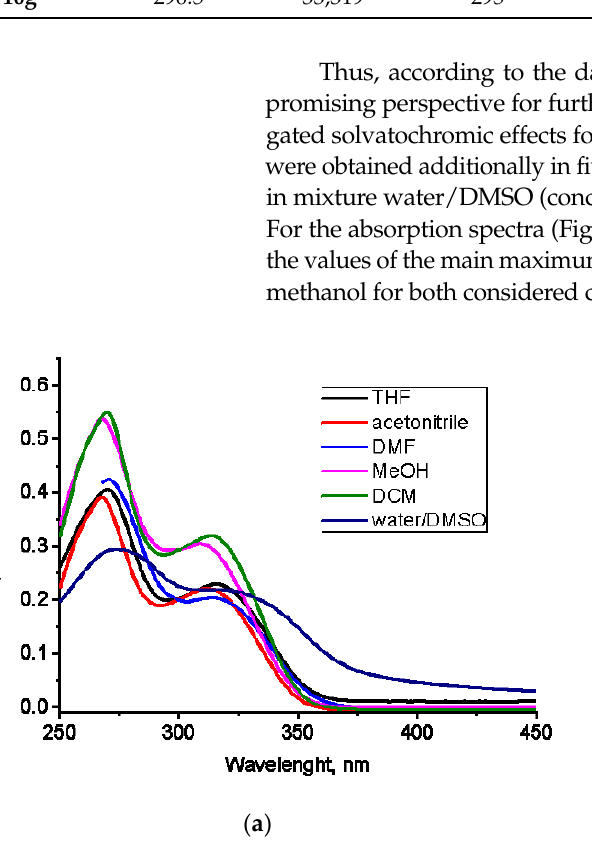
Figure 4. Absorption spectrum of 10f ( a ) and 10g ( b ) in various solvents, C = 1 × 10 − 5 M.